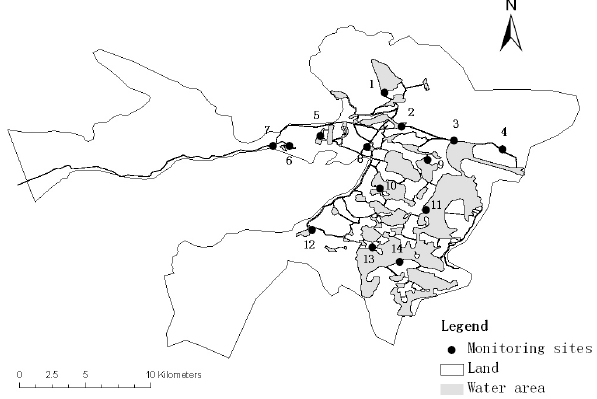
Figure 1. Distribution of the monitoring sites in Baiyangdian Lake.